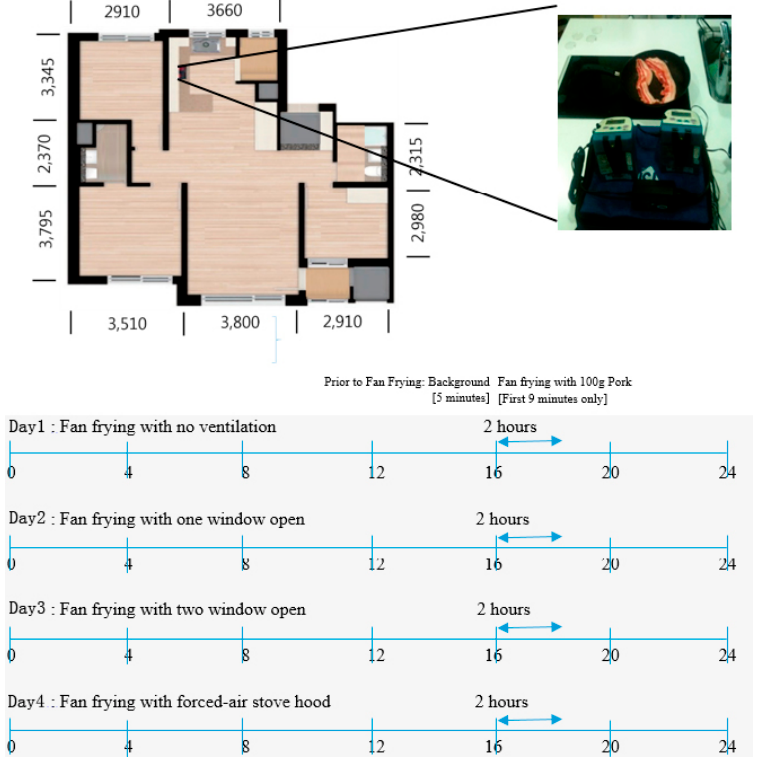
Figure 1. Floor layout of a typical sampling site (unit of length: mm) and schematic of sampling frequency and duration.